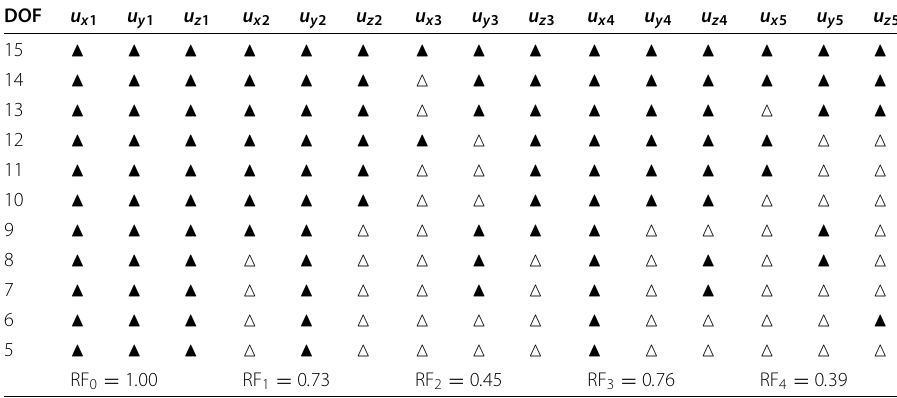
Table 3 BTD models for 0/90/0, R/a = 5 , a/h = 10